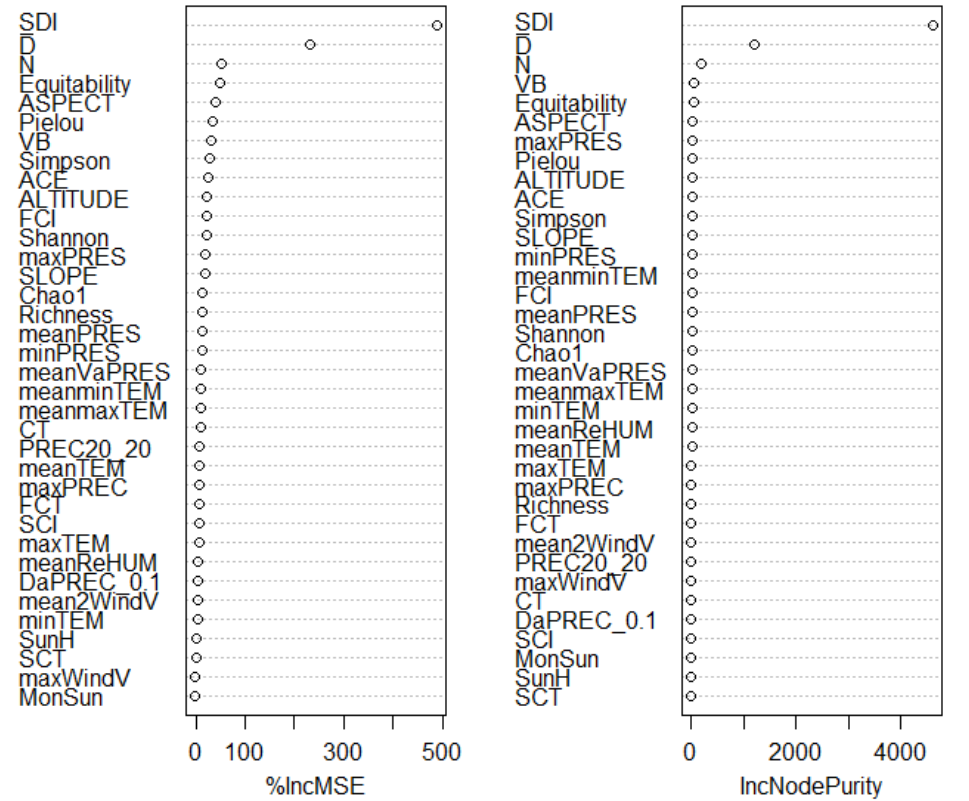
Figure 5. Random Forest. Scatter plot of the importance measure of the output variable.